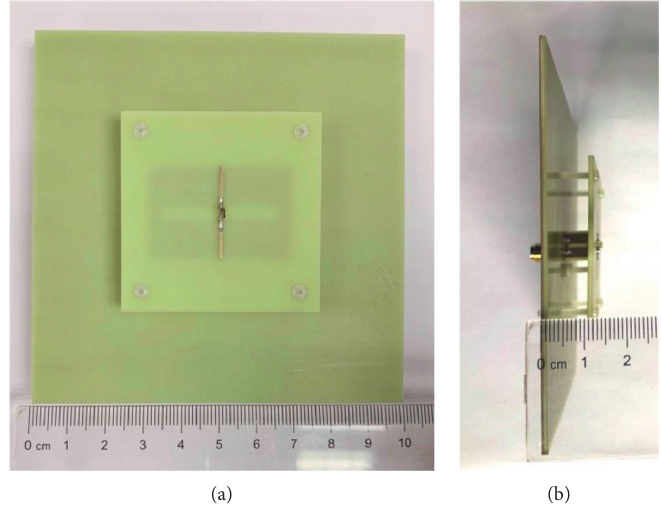
Figure 5: Photograph of the antenna prototype: (a) top view and (b) side